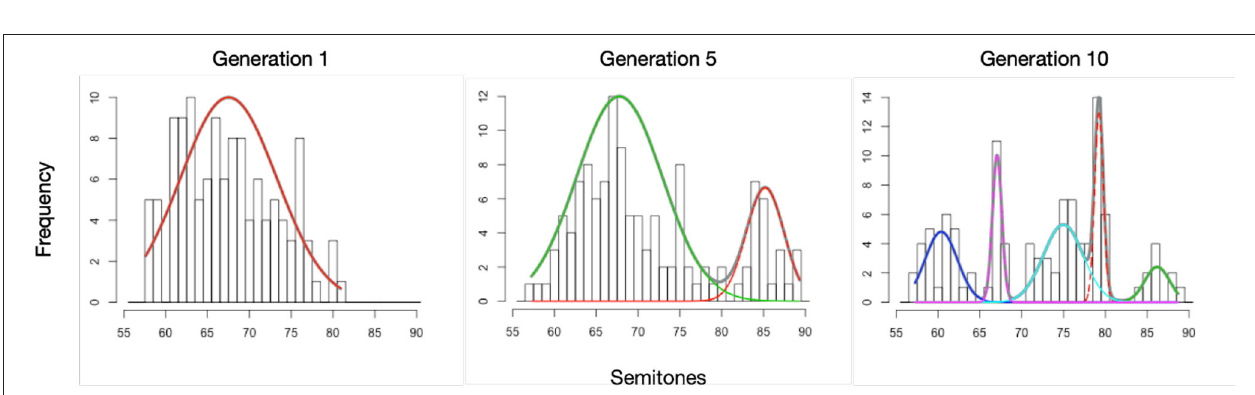
FIGURE 5 | Chi-square ( χ 2 ) statistic measured for each generation in each chain to test for non-uniformity of tone target distributions. The plotted shape of the datapoint indicates whether the tone target distribution is significantly non-uniform ( p < 0.001). The blue line shows a linear model fit over all data and the grey area is the 95% confidence level interval.